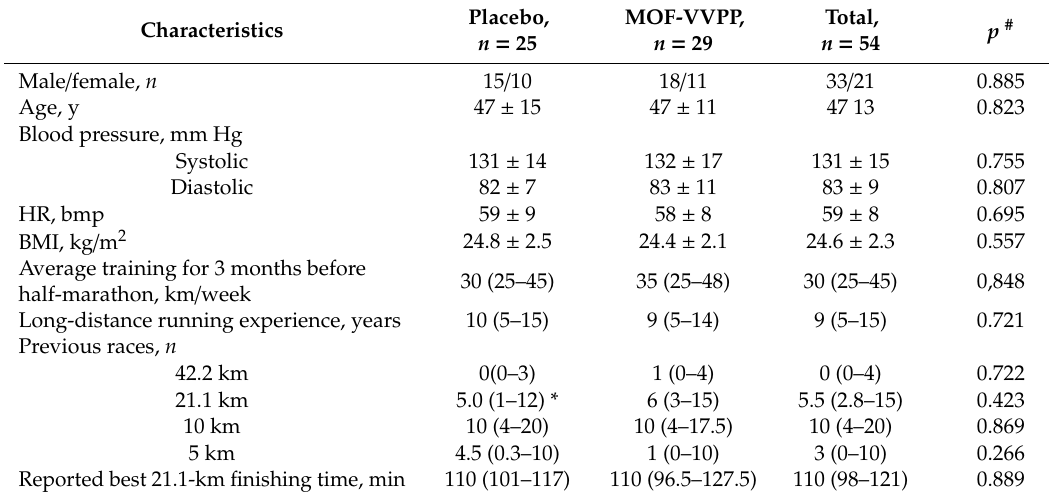
Table 2. General characteristics of the study